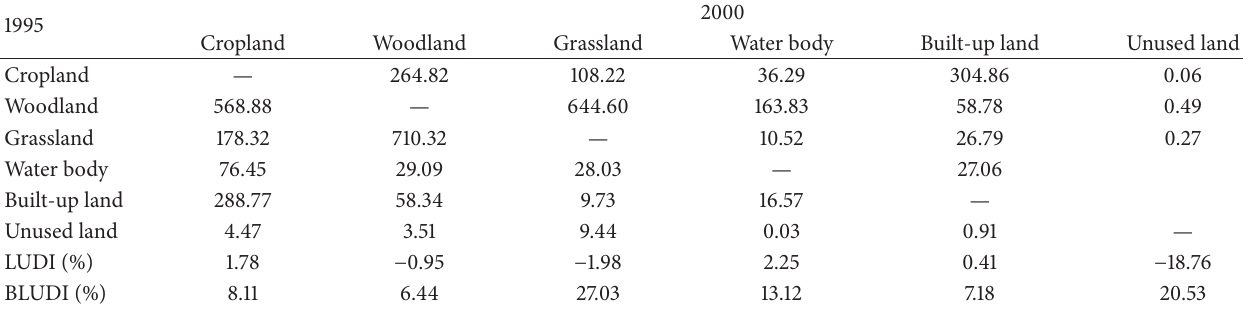
Table 2: Land use change detection matrix in the period of 1995–2000 (km 2 ).